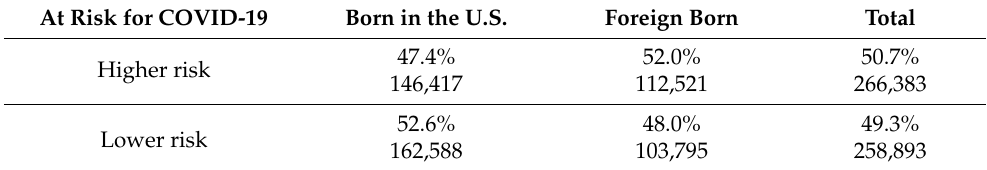
Table 9. Hispanics Diagnosed with High-Risk Pre-Existing Health Conditions by Birthplace. At Risk for COVID-19 Born in the